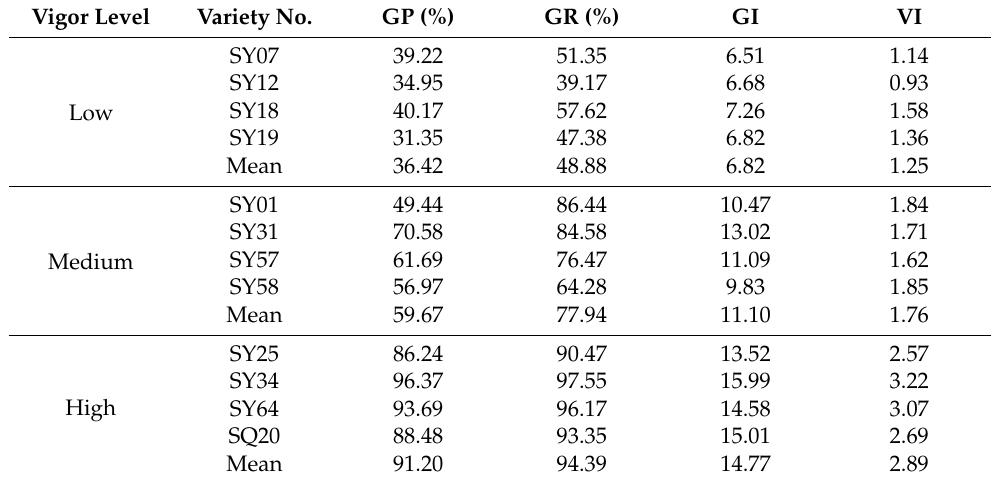
Table 5. Seed vigor indexes of 12 representative soybean strains with different vigor